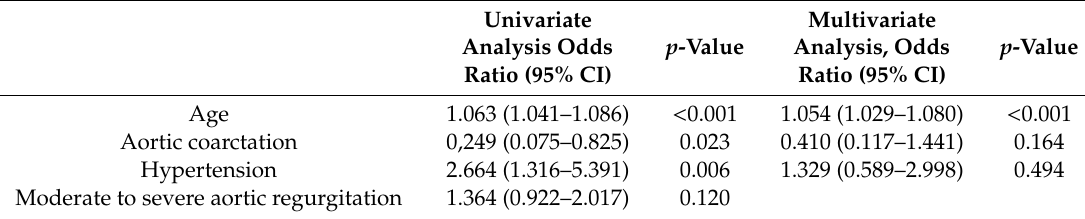
Table 3. Predictors of acute aortic